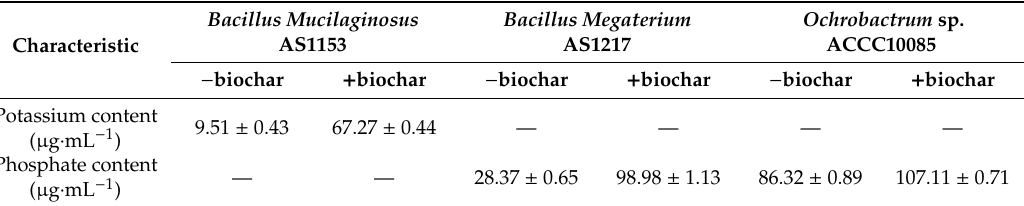
Ochrobactrum sp. ACCC10085